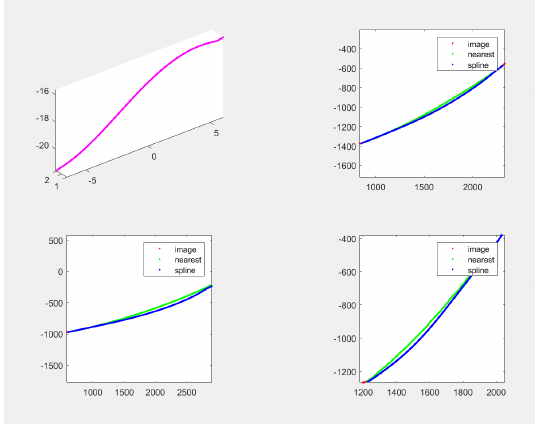
Figure 10 indicates the reprojection results before the optimization process, and Figure 11 depicts the final optimized results. The upper left on both figures are one of the reconstructed power lines and the rest are related reprojection images on three input images. The optimized back-projected 3D Figure 6. Original segmented images lines are aligned better with the detected 2D line segments, showing the effectiveness of the proposed method.